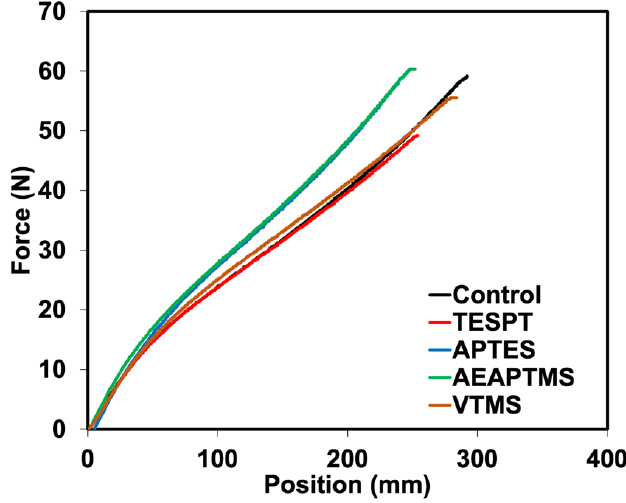
Figure 8. Tearing force as a function of extension of NR/HNT composites containing various content of BFA.